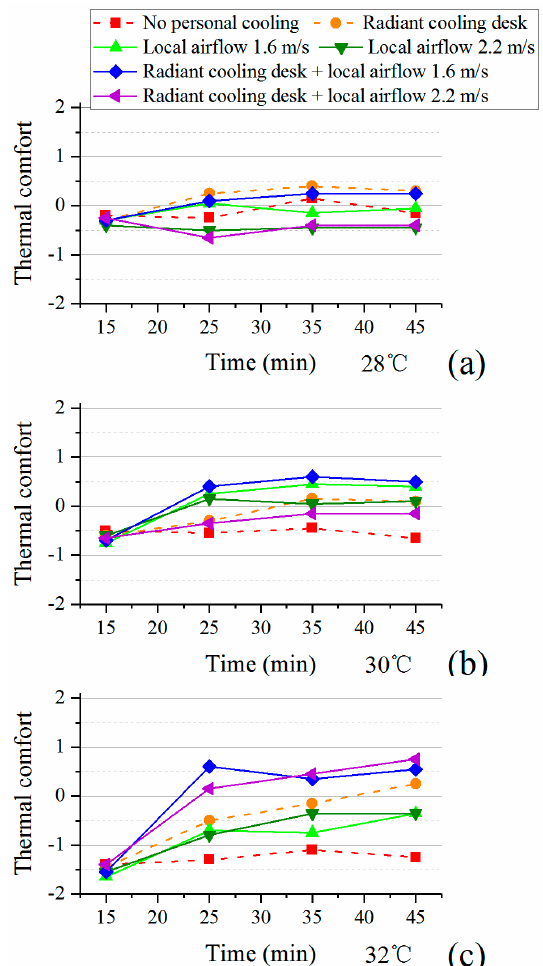
Figure 5. Thermal comfort with personal cooling systems: ( a ) 28 ◦ C; ( b ) 30 ◦ C; ( c ) 32 ◦ C.